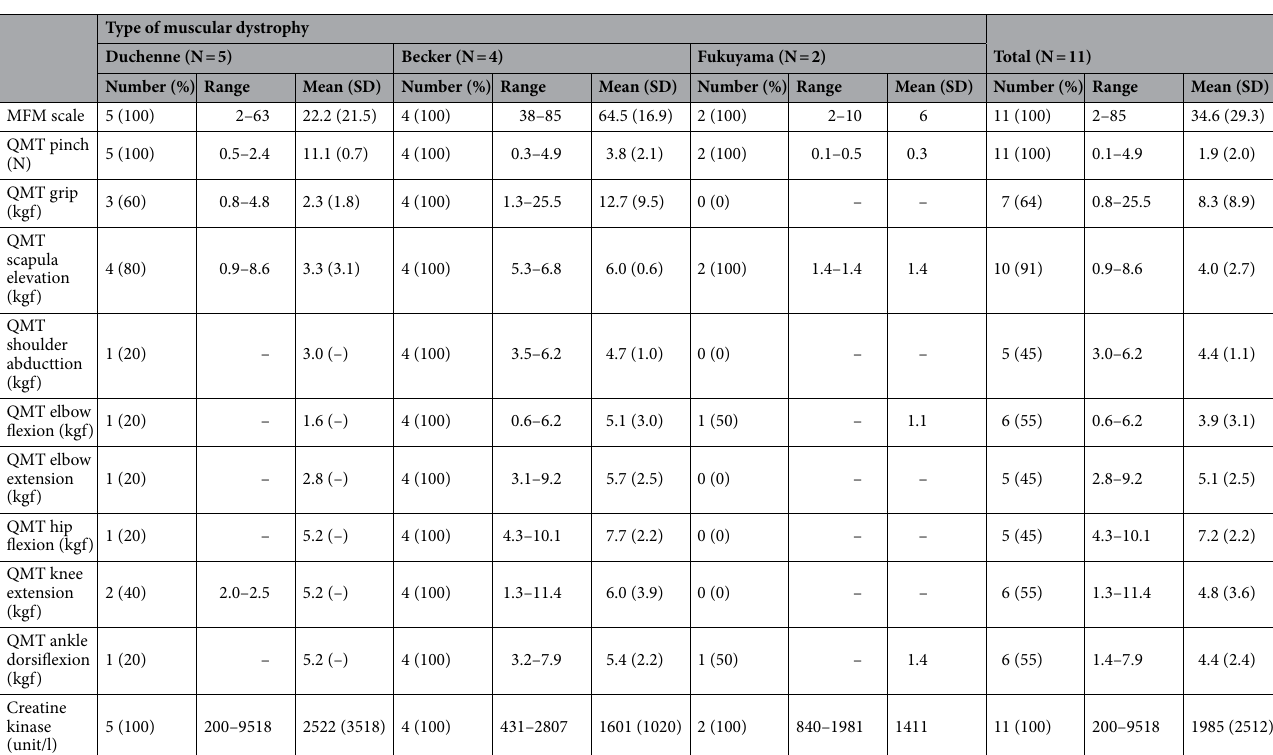
Table 2. Mean MFM scale and QMT scores of participants before resveratrol